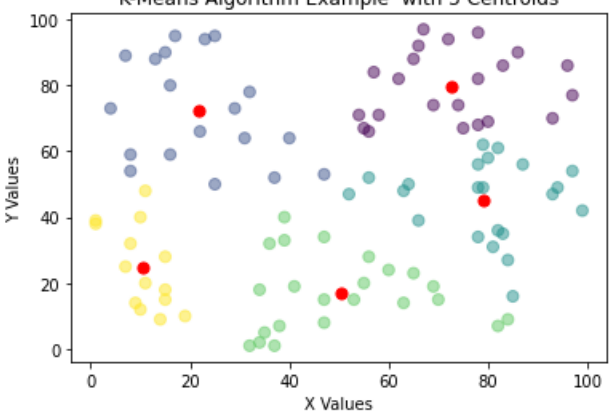
Figure 2. K-means algorithm plot example with random